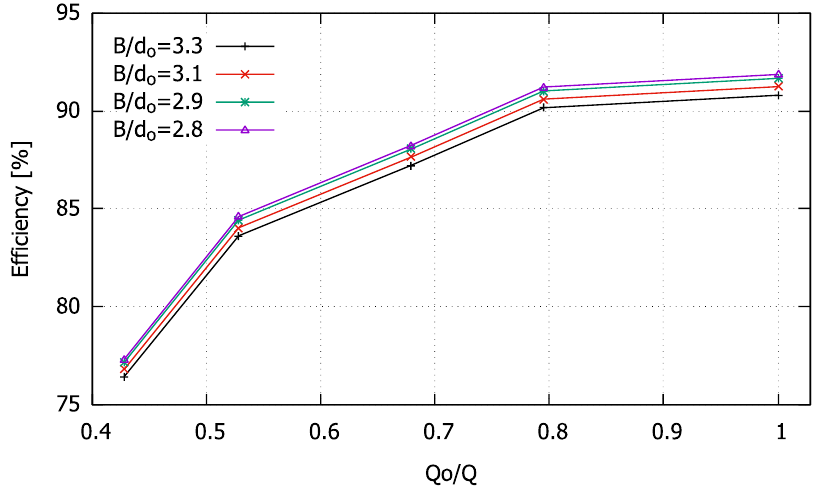
Figure 14. Influence of B parameter.